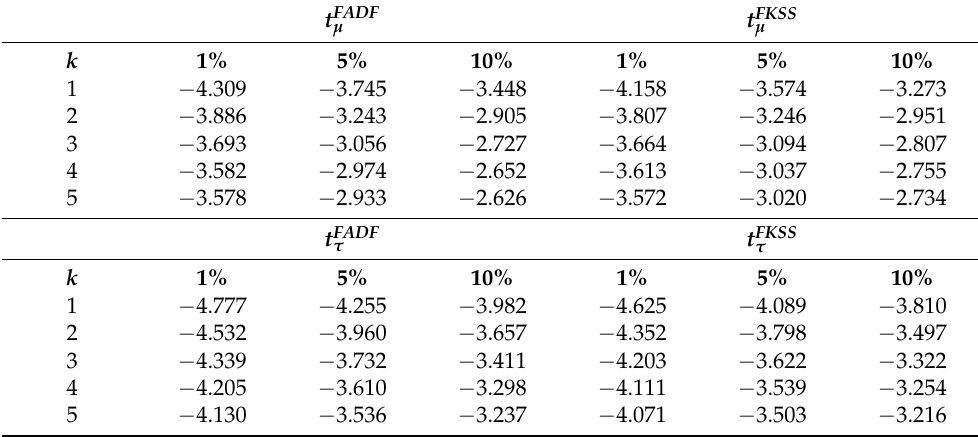
Table 1. Asymptotic critical values of FADF and FKSS test statistics. t FADF µ t FKSS µ k